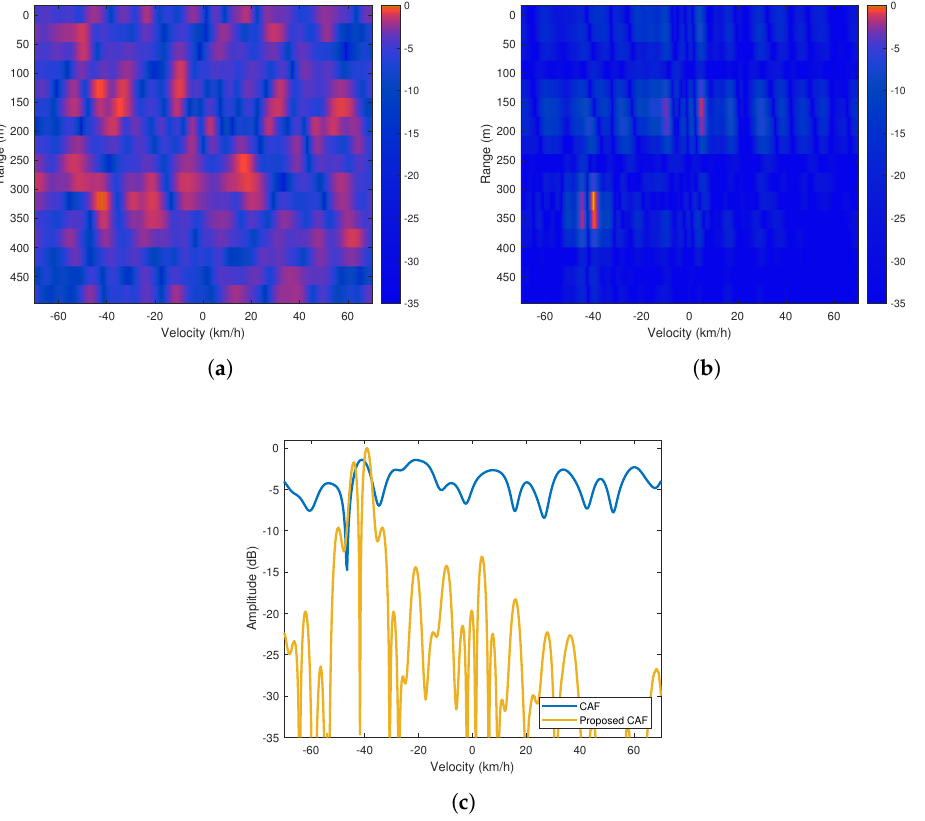
Figure 13. ( a ) CAF range-Doppler map ( b ) Proposed method’s range-Doppler map ( c ) Doppler profiles of the maps at 320